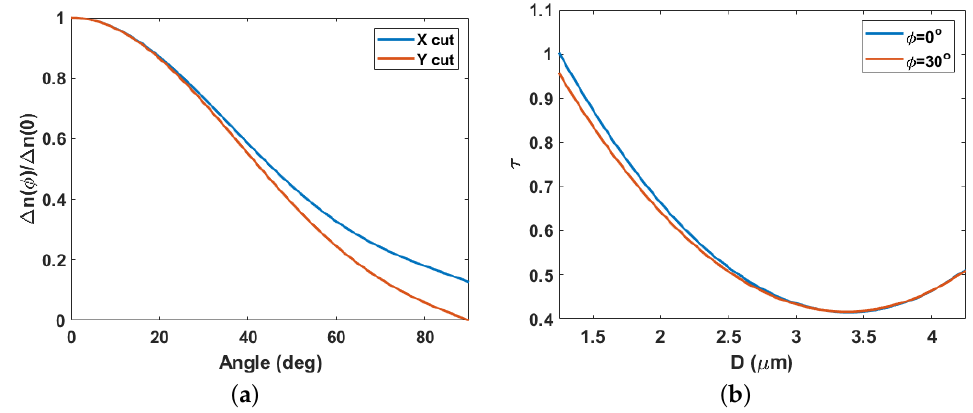
Figure 4. Change in ( a ) refractive index (neglecting the change in τ ) and ( b ) τ for varying D. However, due to the anisotropic behaviour of LiN, the RF dielectric constant and optical refractive index changes with the orientation of the device. This results in a change in the distribution of RF and optical field, varying the overlap factor τ . Variation in the ( τ ) for an orientation of 30 ◦ is depicted in Figure 4b. The results in the figure suggest that τ reduces by a factor of 0.91 (at the previously determined value of D) due to the change in field distribution within the